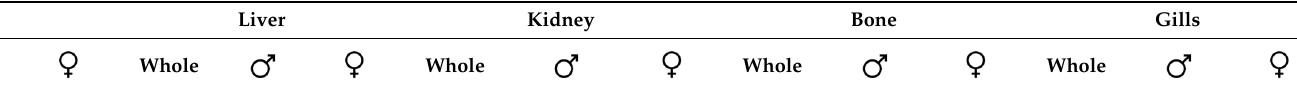
Figure 4. Correlations between tissues for THg concentration in ABFT. The solid line indicates a p-value < 0.01, and a dashed line indicates a p-value < 0.05. The thickness of the line represents the strength of the relationship.